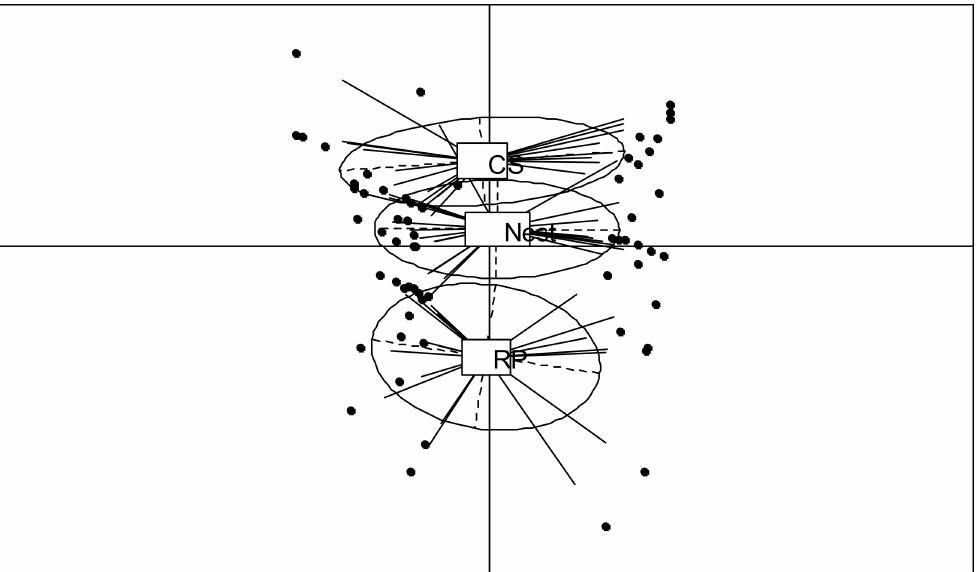
Figure 3. Principal component analysis results for projection of NIRS spectra of refuse piles (RP), soil of P. fallax nests, and control soil (CS), in the plane defined by the first two factors for the 20-year site.